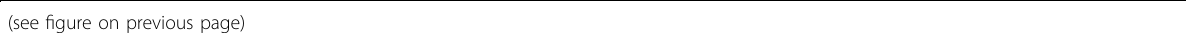
Fig. 6 The administration of DRD5 agonist attenuates the colitogenic phenotype of mice. A , B Age-matched male WT and DRD5 − / − mice ( n = 5 mice per group) were i.p. injected with D1-like agonist SKF-38393 at a dose of 10 mg/kg daily during DSS treatment. Weight changes ( A ) and disease activity index (DAI) ( B ) were monitored daily. C Gross morphology images of the DSS-induced colitis in WT mice or DRD5 − / − mice that were injected with DRD5 agonist, and colon length was measured on day 9. D Representative H&E-staining section of colons and histology score of mice in ( A ). Scale bars, 4×, 500 μ m; 20×, 200 μ m. E The concentration of TNF- α , IL-6, and CCL2 in the serum of WT and DRD5 − / − mice treated with SKF38393. Data are pooled from three independent experiments. Error bars show means ± SEM. * P < 0.05, ** P < 0.01; *** P < 0.001; NS, not signi fi cant. multiple unpaired t -tests for ( A , B ) and One-way ANOVA with Sidak ’ s multiple comparisons test for ( C – E